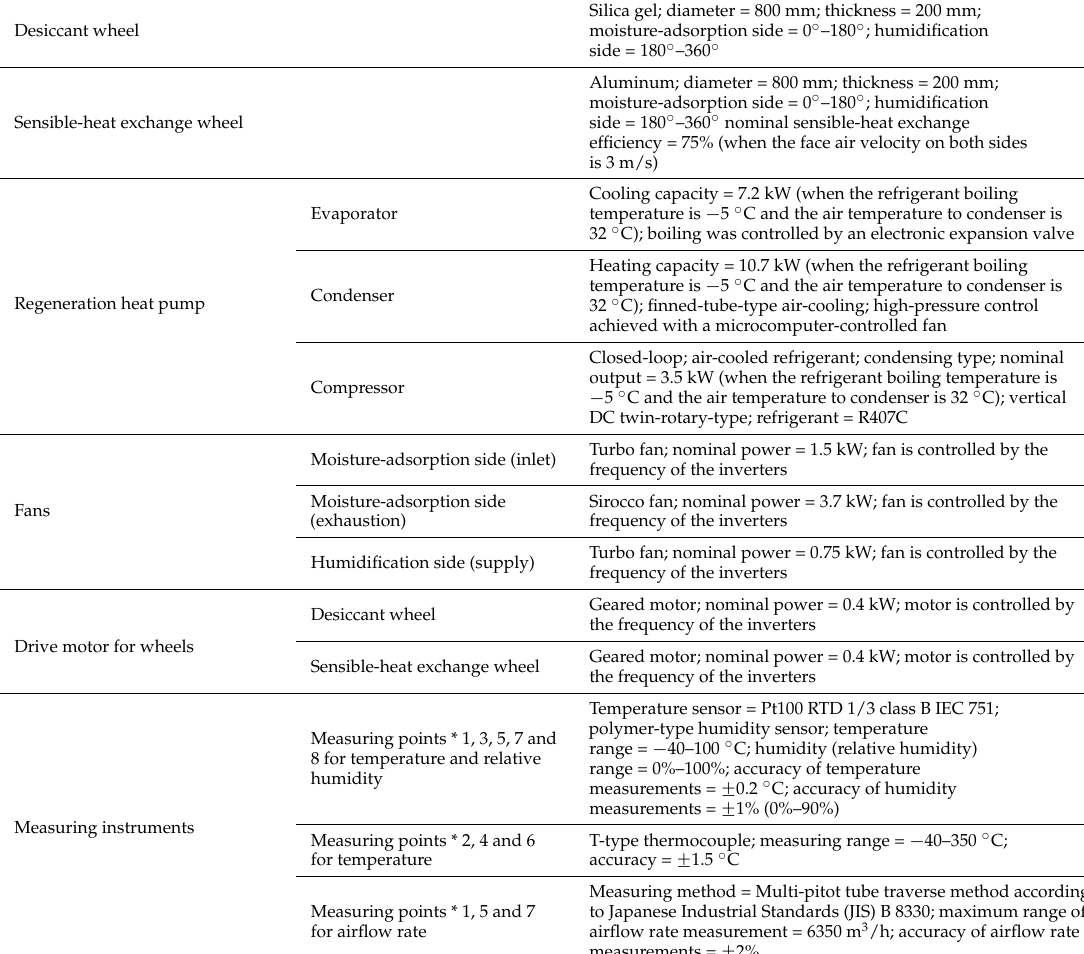
Table 1. Specifications of the experimental